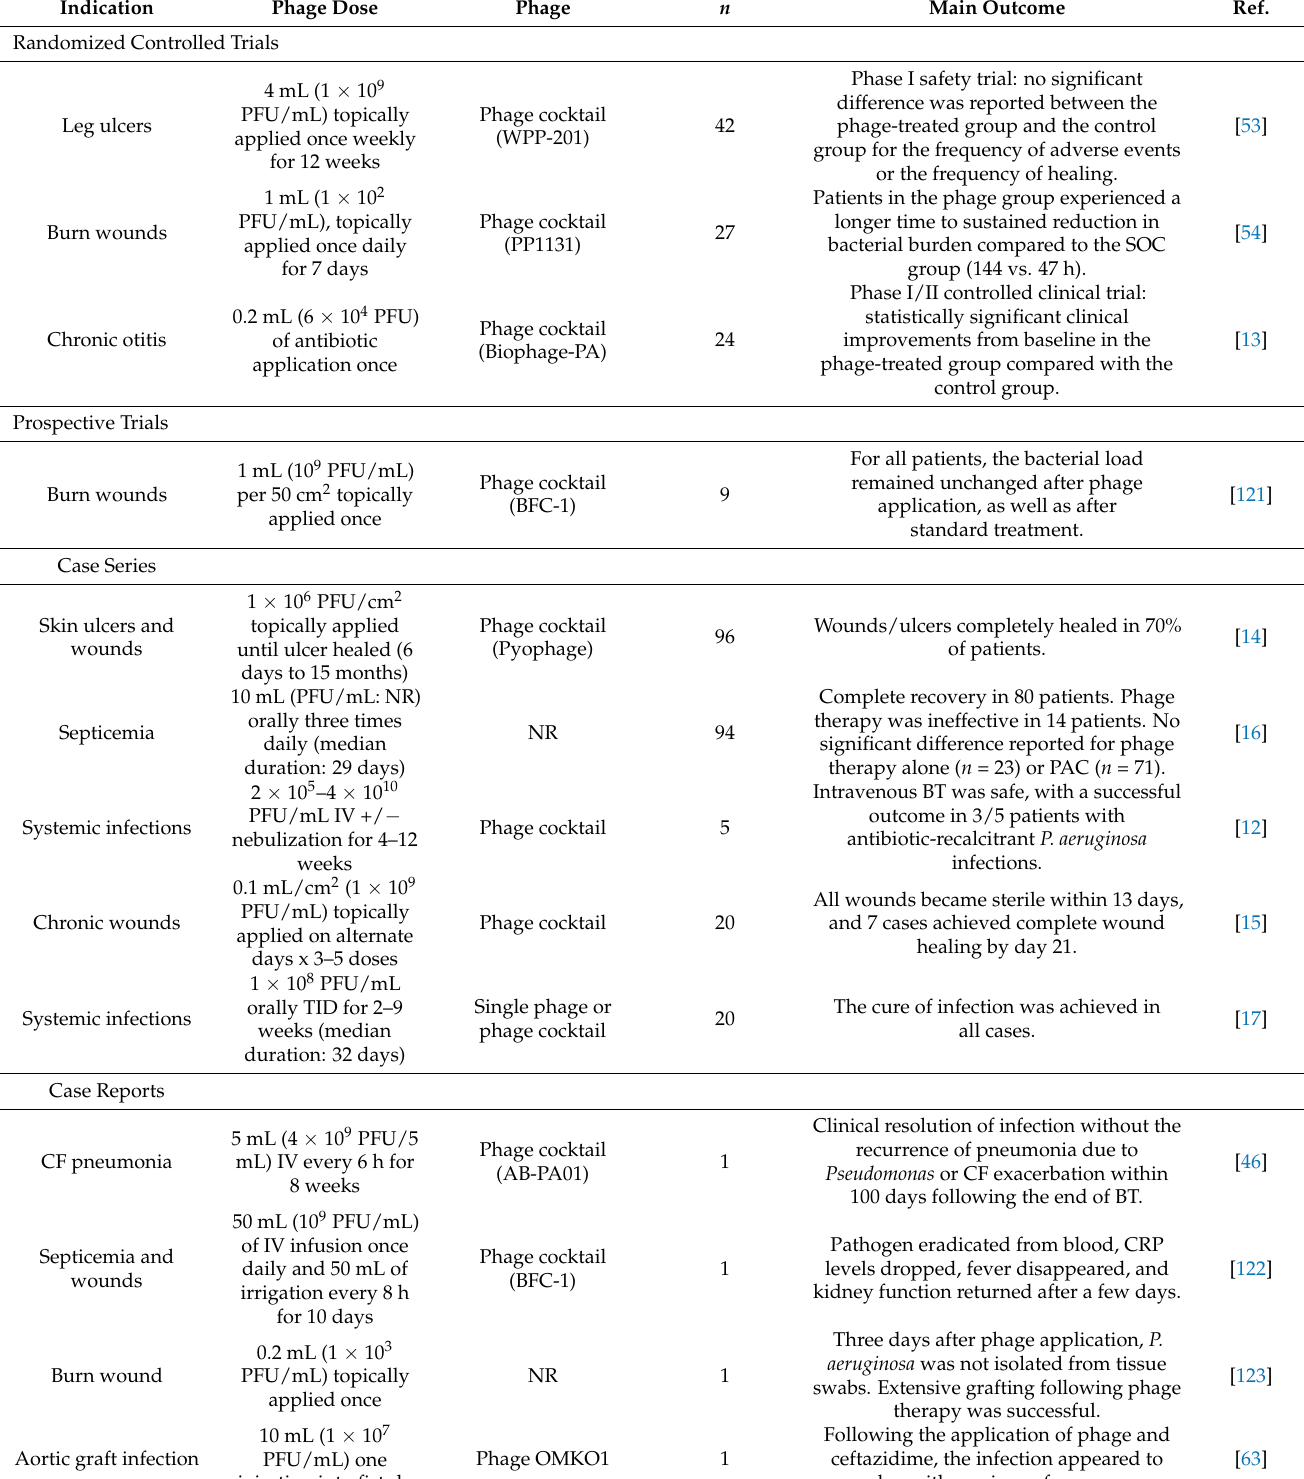
Table 1. Summary of the most relevant studies with targeted P. aeruginosa phage therapy in humans. Indication Phage Dose Phage n Main Outcome